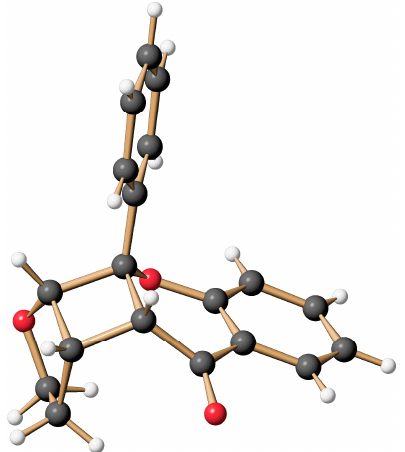
Figure 1. Structure of the photocycloadduct 6 in the crystal.